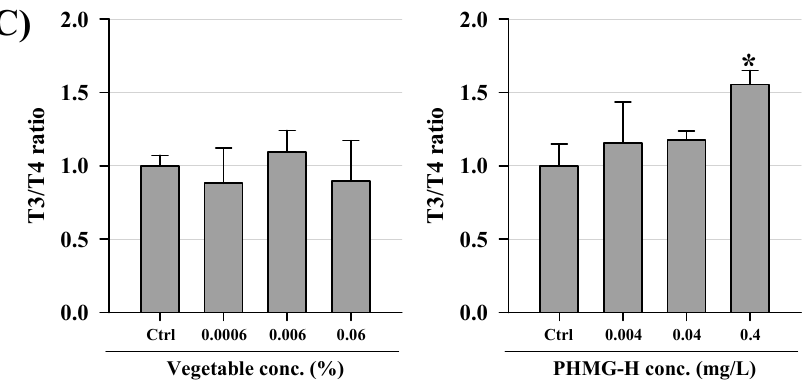
Figure 2. Concentrations of ( A ) triiodothyronine (T3), ( B ) thyroxine (T4), and ( C ) T3/T4 ratio in zebrafish larvae after exposure to Vegetable HD and PHMG-H for 7 d. The values are expressed as mean ± standard deviation of four replicates. Asterisk indicates significant difference from the control group ( p < 0.05).